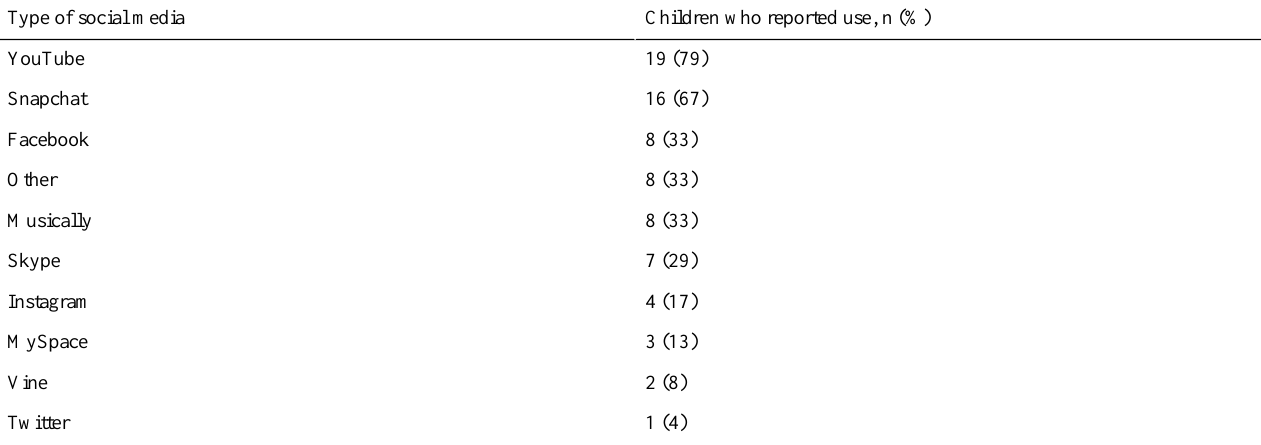
Table 1. Children’s reported social media use